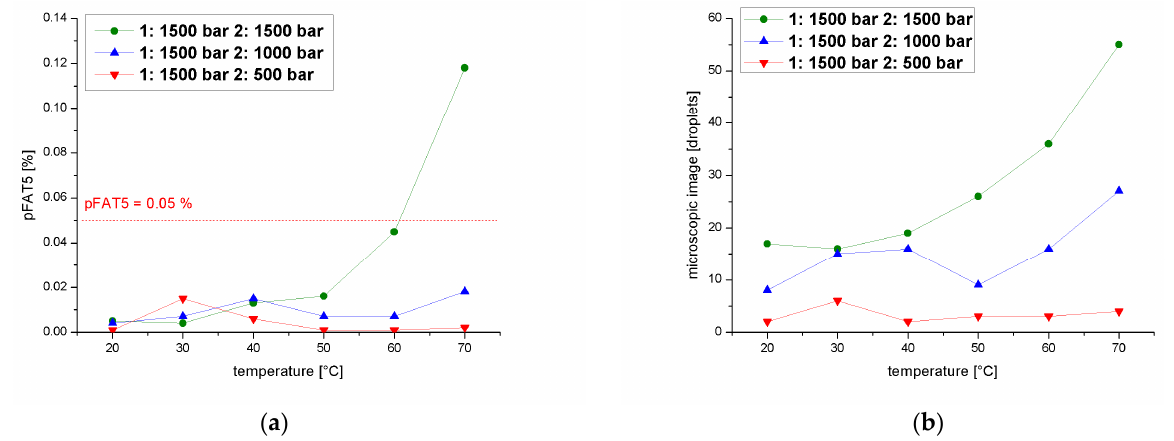
Figure 10. Effect of a two-cycle process with the first cycle at 1500 bar on the pFAT5 value and droplet counts. ( a ) The pFAT5 value of the second homogenization cycle as a function of temperature at different operating pressures (500–1500 bar). ( b ) The droplet count of the second homogenization cycle as a function of temperature at different operating pressures (500–1500 bar).